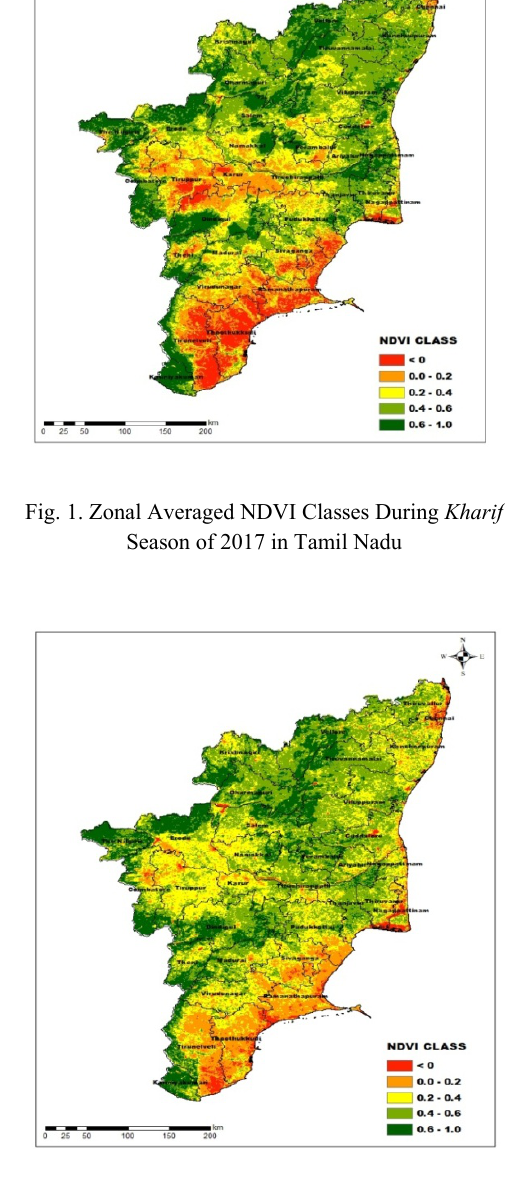
Fig. 2. Zonal Averaged NDVI classes During Rabi S eason of 2017 in Tamil Nadu